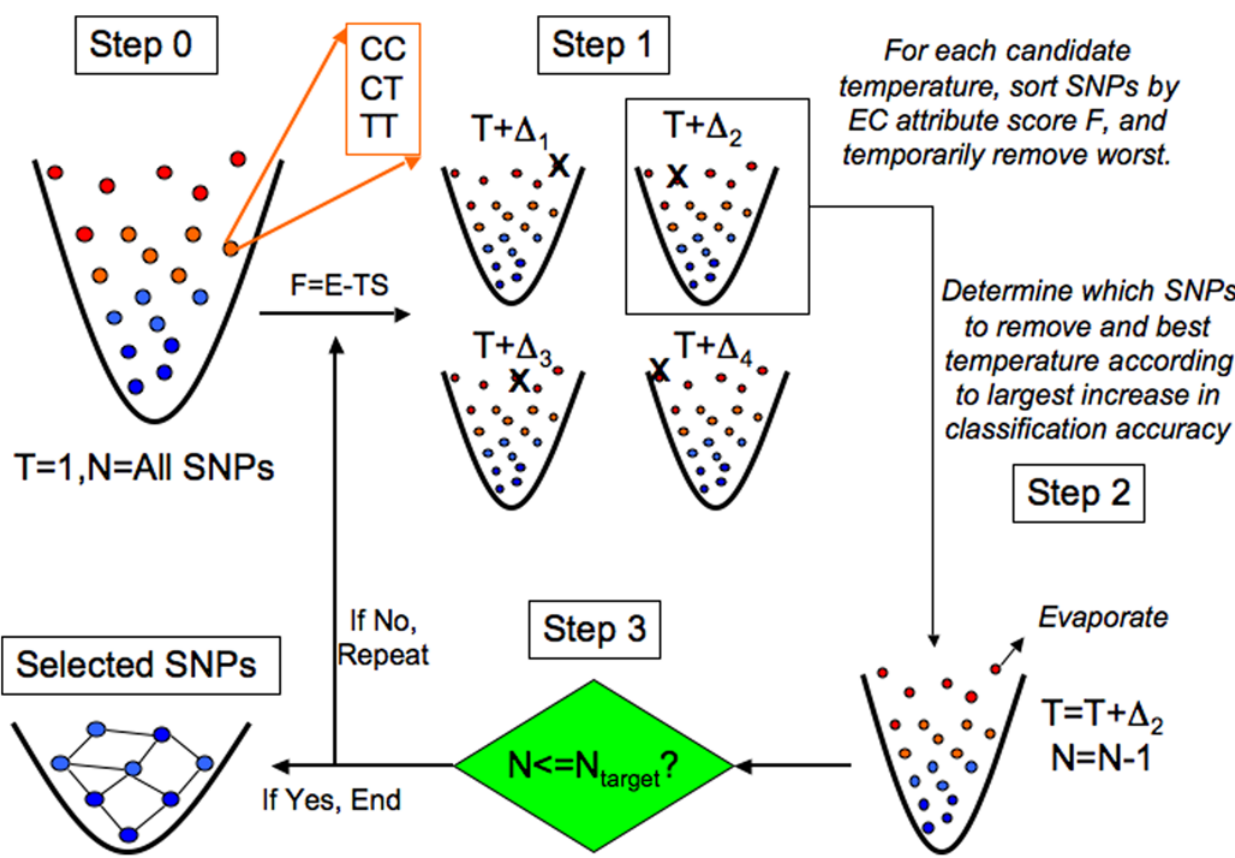
Figure 5. Evaporative Cooling (EC) feature selection algorithm. Each locus is conceptualized as a discrete-state particle with available states corresponding to its genotypes (e.g., CC, CT, TT) in a fictitious potential well, which controls the number of SNPs filtered. The information free energy F of each SNP is determined by its relevance to the phenotype. SNPs less relevant to the phenotype have higher free energy (more noise) and are positioned near the top of the potential well. Interaction (Relief-F, represented by E ) and independent (Random Forest, represented by S ) effect scores are coupled by the optimization parameter T , analogous to temperature in the free energy F . Initially, the information free energy F is calculated for all SNPs in the data set with the coupling constant T=1 (step 0). The coupling constant is varied about unity so that the set of SNPs is removed that gives the largest increase in classification accuracy over the previous iteration (step 1). This defines the updated coupling T and yields the new collection of SNPs with the SNPs evaporated with the most noise (least relevance to the phenotype) (step 2). If the target number of SNPs is reached (step 3), then a genetic-association interaction network (GAIN) is generated from the collection of SNPs that have been enriched for interactions and relevance to the phenotype by EC. Otherwise, if the target number of SNPs has not been reached yet, the coupling parameter again is varied about the previous coupling and the evaporation process is repeated. Permutation is used to select the target number of SNPs.